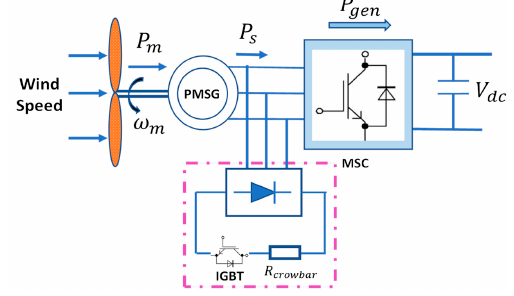
Figure 15. An active crowbar circuit [106].